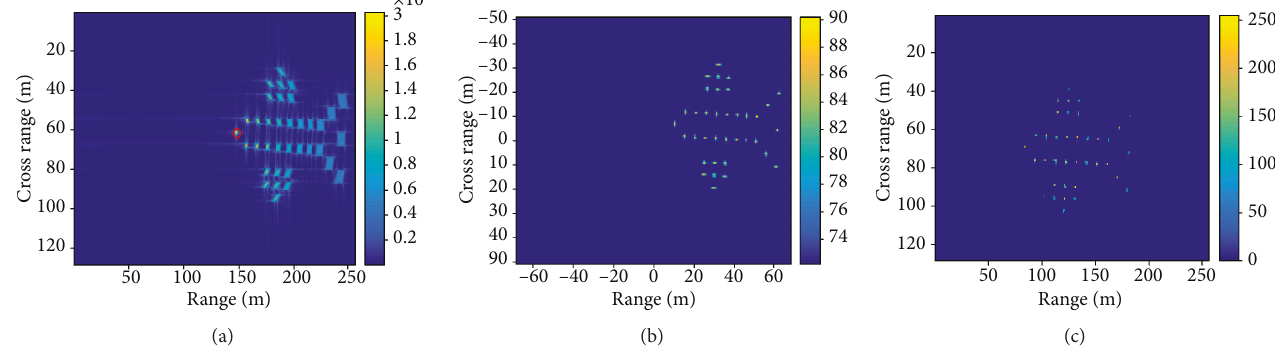
Figure 4: Imaging results with the target ’ s motion parameters P1. (a) RD algorithm. (b) Keystone transform. (c) The proposed method.